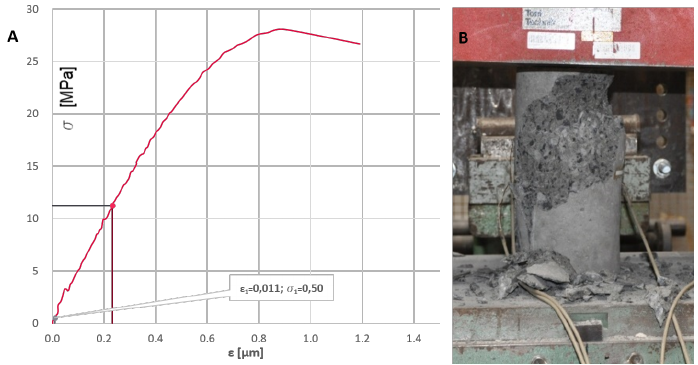
Figure 3. The σ - (cid:101) curve ( A ), and the view of the failed specimen after compression testing ( B